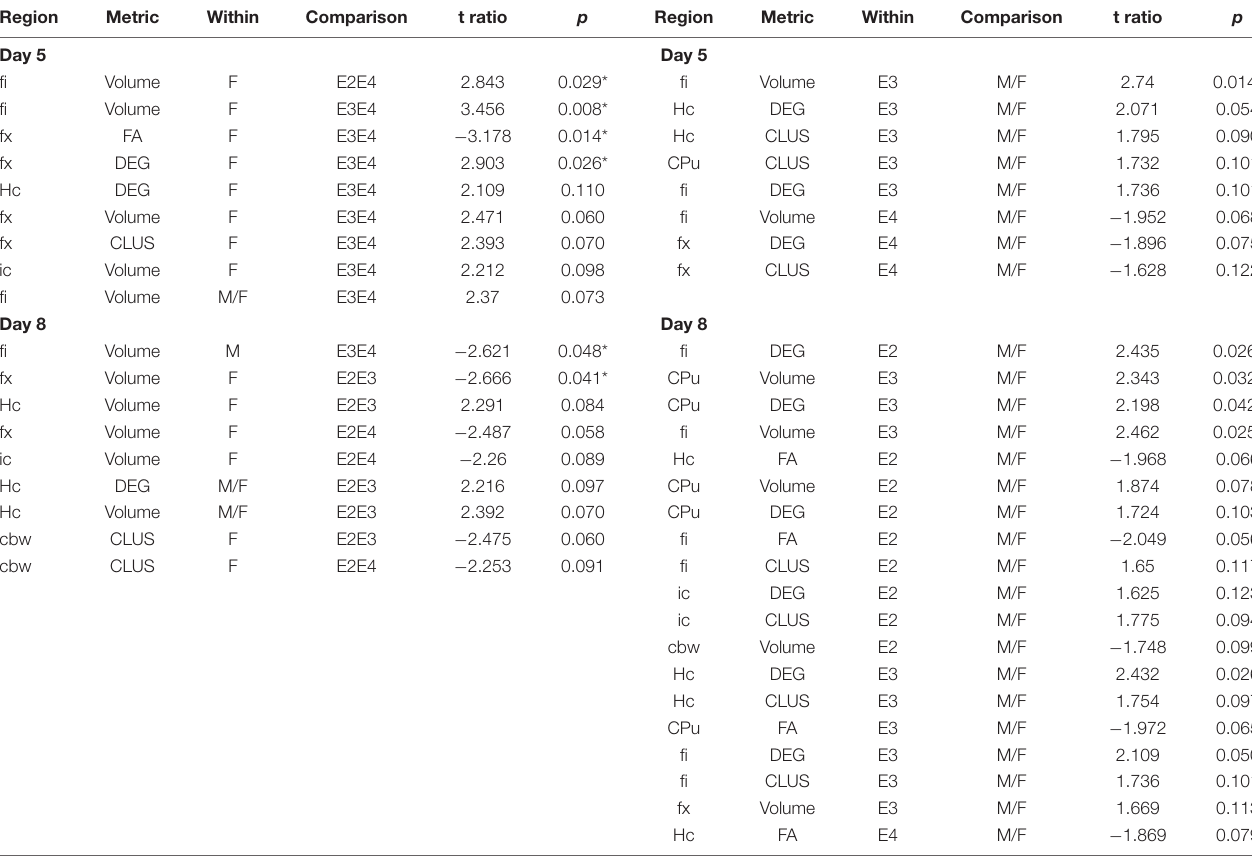
TABLE 4 | Summary of AWN ∼ MRI metrics comparisons.